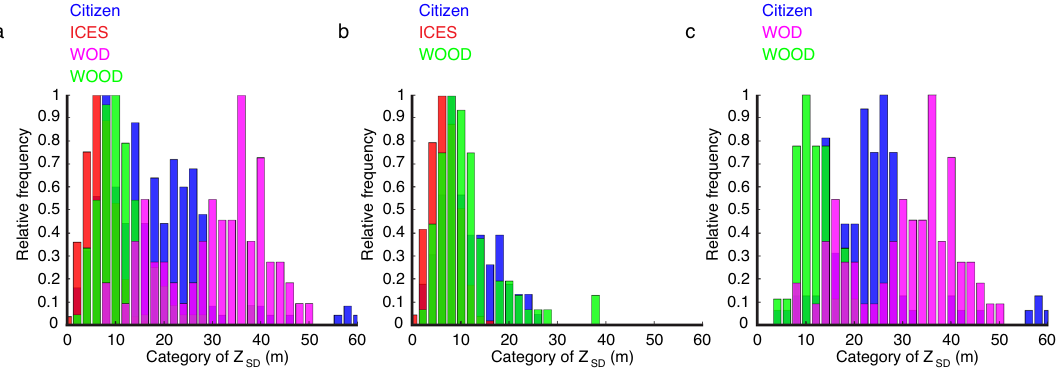
Figure 3. Histograms of Z SD for the three scientific programmes and for citizens. ( a–c ) Histograms for WOD (magenta), WOOD (green), ICES (red) and citizen (blue) Z SD data for shelf + open-ocean, shelf, and open-ocean, respectively.